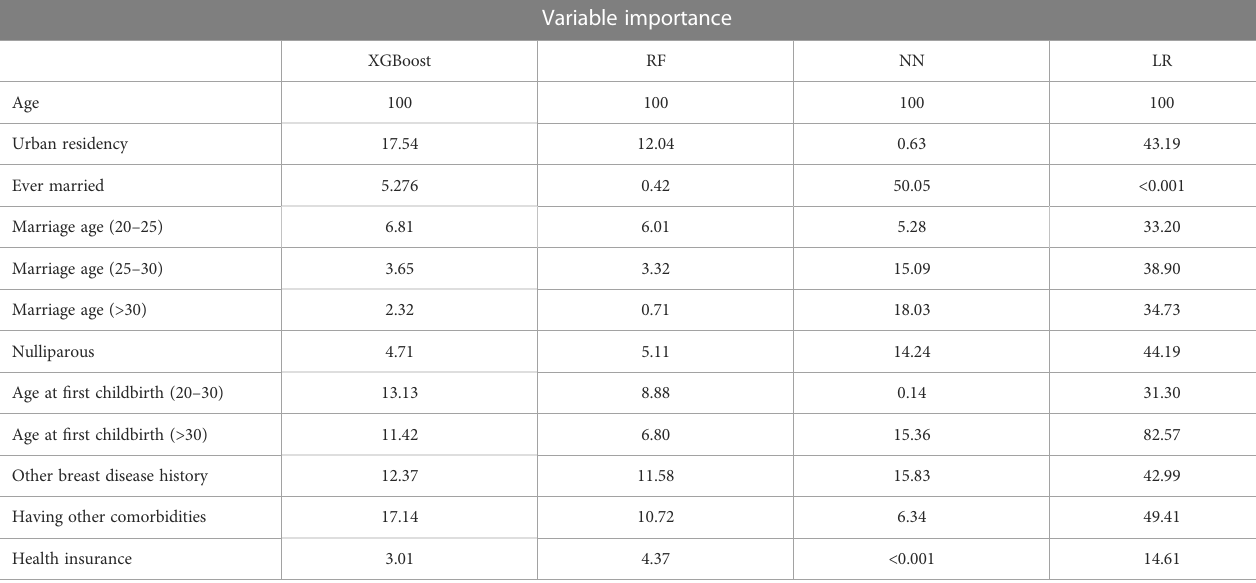
TABLE 4 Variable importance.